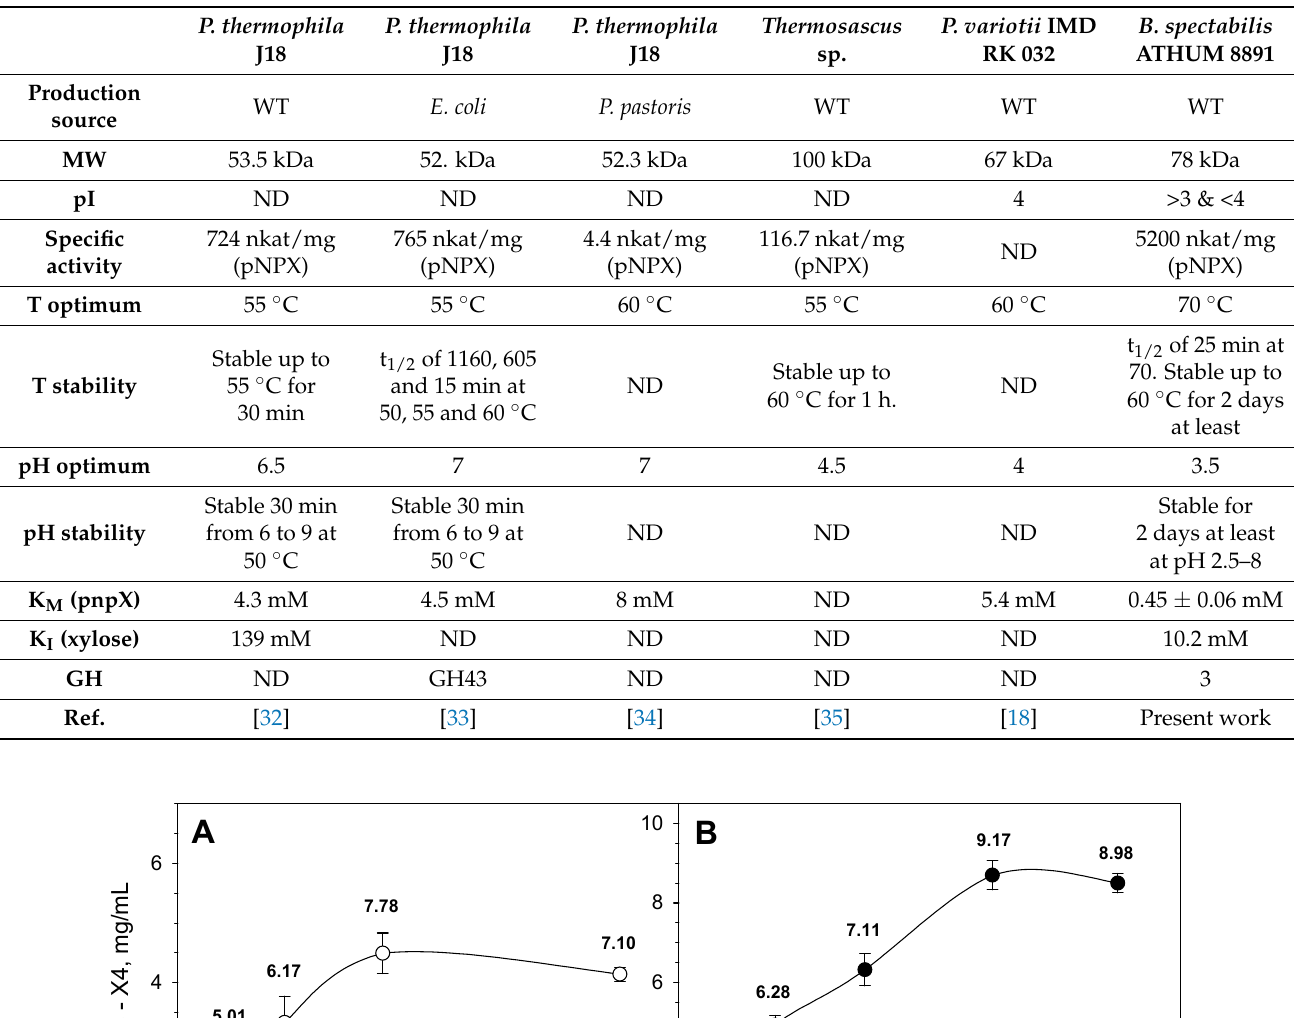
Table 4. Biochemical properties of the characterized β -xylosidases originated from Thermoascaceae members.